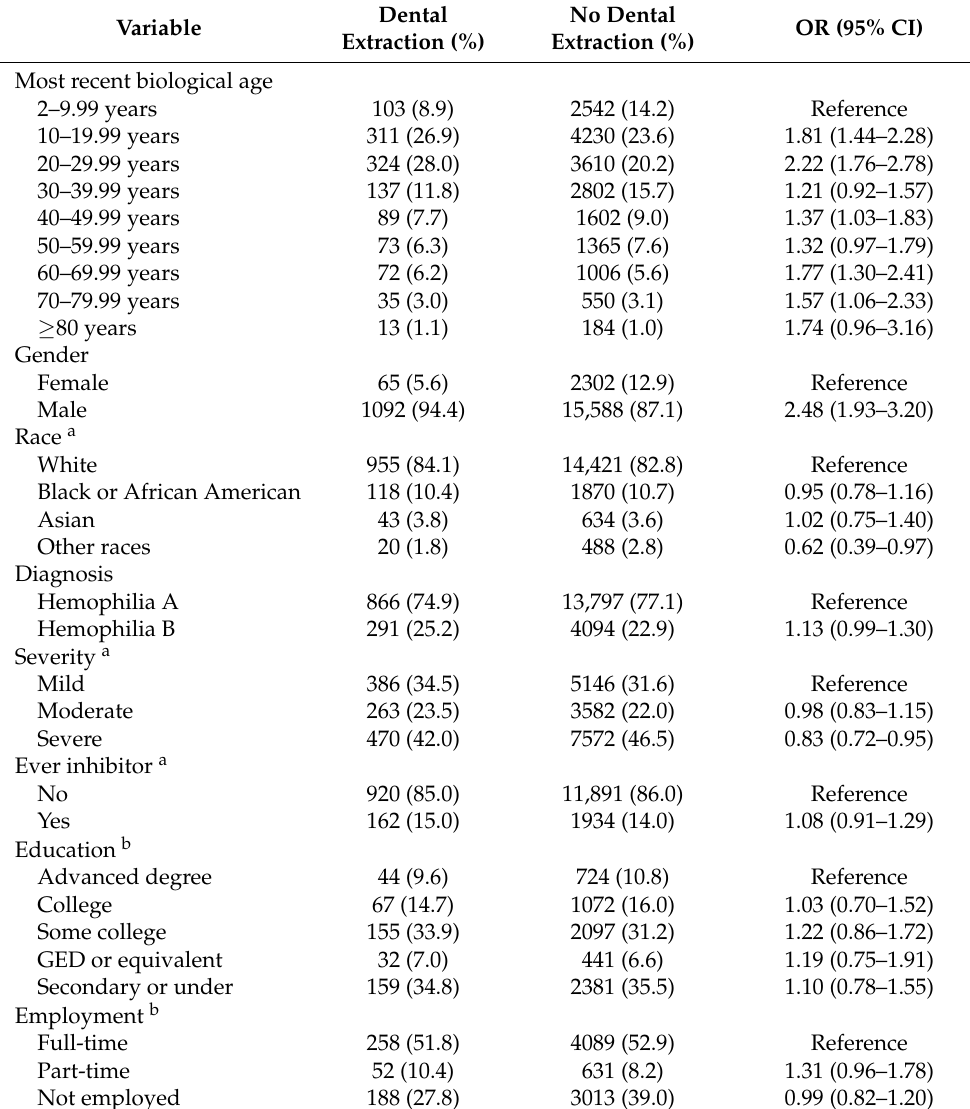
Table 1. Sociodemographic and clinical characteristics of hemophilia patients with and without dental extraction, and overall hemophilia patients,